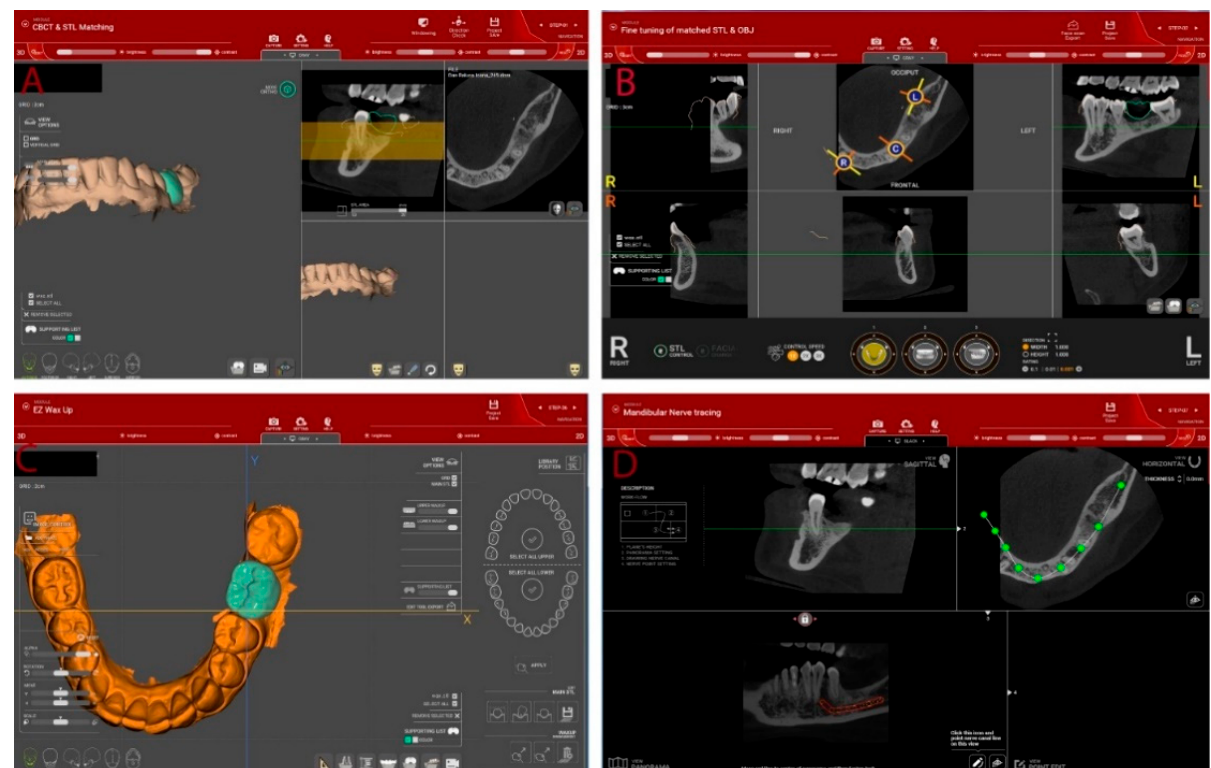
Figure 2. Dental implants insertion planning in R2GATE software. ( A ) Importing digital or digitalized impression (standard tessellation language (STL) files) and cone beam computed tomography (CBCT) Digital Imaging and Communications in Medicine (DICOM) files; ( B ) Superimposing files using the “best fit” algorithm; ( C ) Design of the prosthetic restoration (digital wax-up); ( D ) Marking the alveolar nerve trajectory.